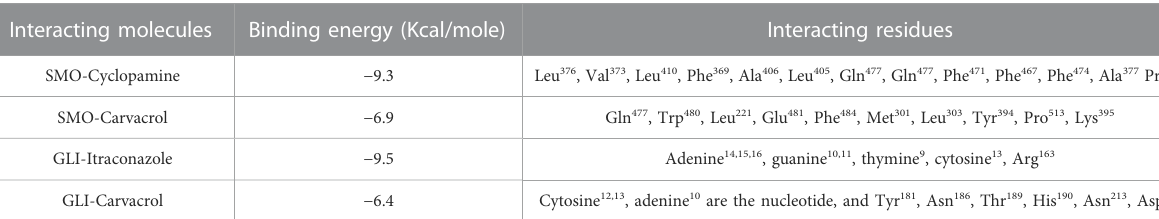
TABLE 2 Binding energy of carvacrol, cyclopamine and itraconazole with Gli1 and Smo1. Interacting molecules